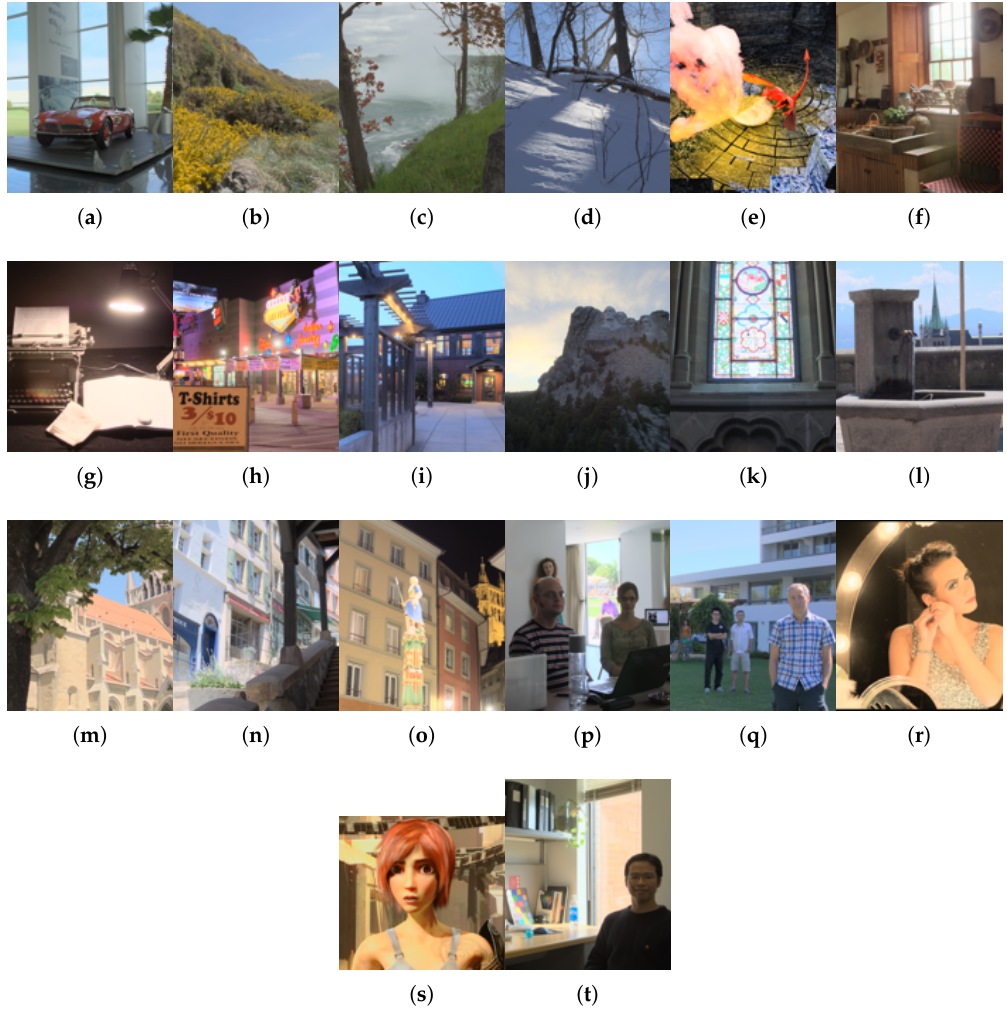
Figure A3. Tone-mapped version (Reinhard et al. TMO [54]) of Korshunov et al. reference images. From left to right and from top to bottom: ( a ) 507 ( b ) BloomingGorse2 ( c ) CanadianFalls ( d ) DevilsBathtub ( e ) dragon_ 3 ( f ) HancockKitchenInside ( g ) LabTypewriter ( h ) LasVegasStore ( i ) McKeesPub ( j ) MtRushmore2 ( k ) set18 ( l )set22 ( m ) set23 ( n ) set24 ( o ) set31 ( p ) set33 ( q ) set70 ( r ) showgirl ( s ) sintel_ 2 ( t )